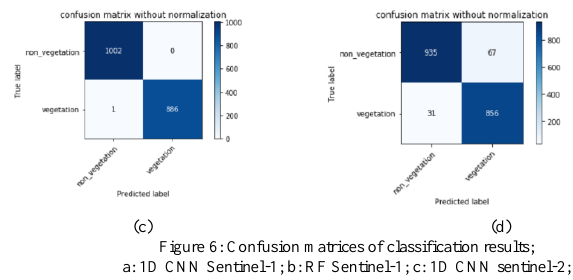
(d) Figure 6: Confusion matrices of classification results; a: 1D CNN Sentinel-1; b: RF Sentinel-1; c: 1D CNN sentinel-2; d: RF Sentinel-2